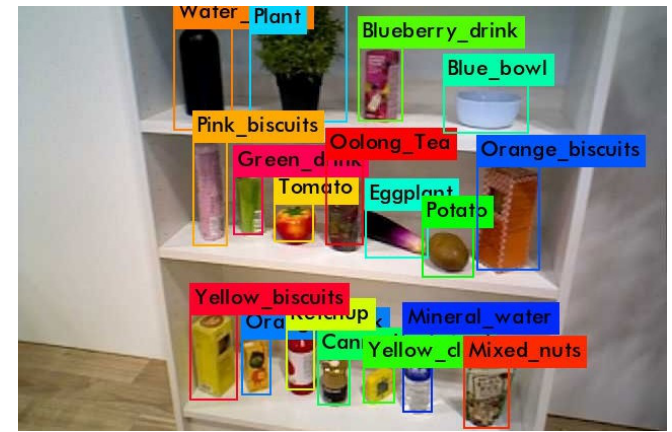
Figure 3. Detected objects and their bounding boxes from a RGB image.